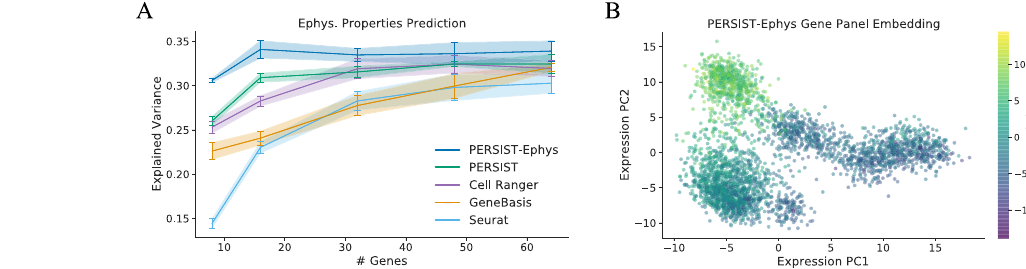
a set of n=341 held-out cells, and error bars represent 95% con fi dence intervals determined by training with fi ve bootstrapped datasets. B Low-dimensional embedding for the PERSIST-Ephys panel containing 64 genes, colorized according to the cells' electrophysiological properties (using the fi rst principal component); the cells are effectively clustered according to their properties, with similar cells appearing nearby in the embedding